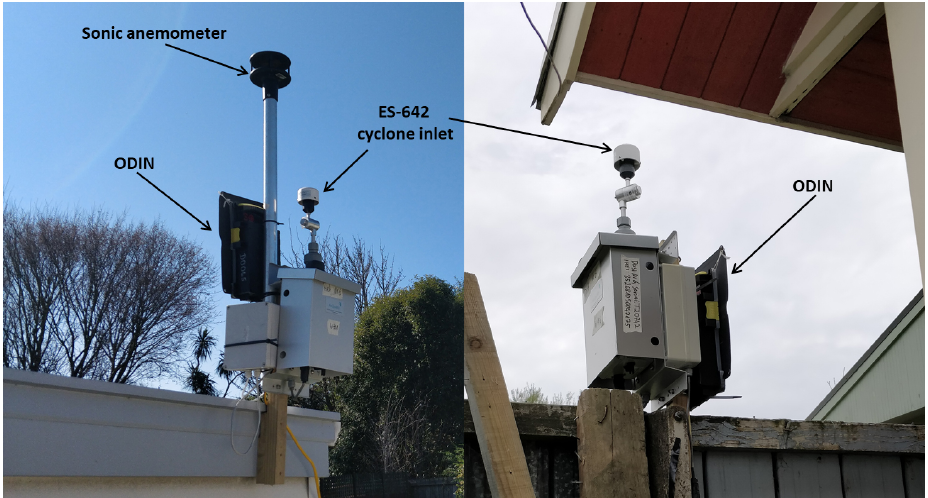
Figure 3. Examples of typical co-located ES-642 and ODIN instals. Note the instrument on the left is a Dust Met Mote with an additional sonic anemometer. An ODIN was co-located with every ES-642 instrument for intercomparison purposes.